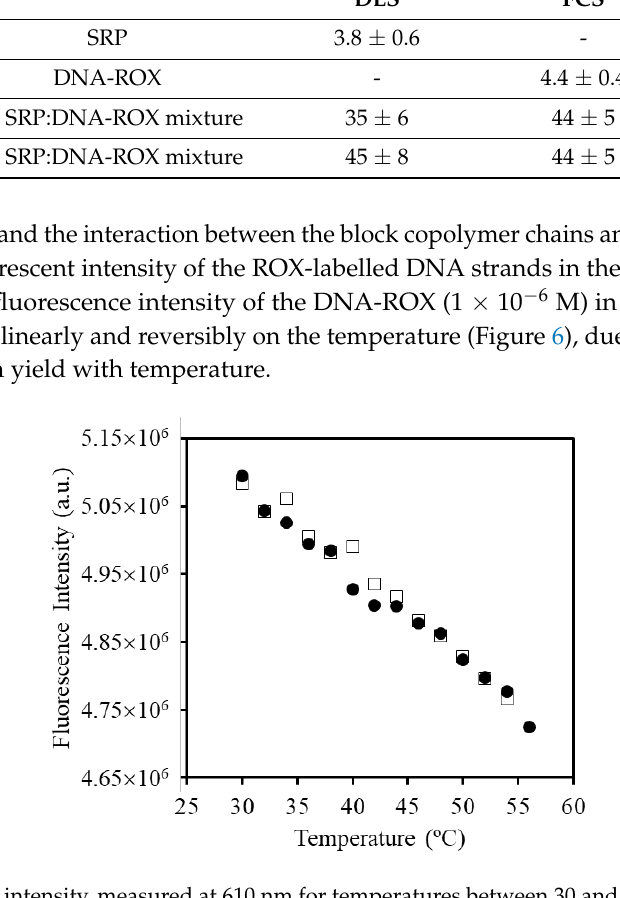
Table 1. Room temperature hydrodynamic diameters obtained for DNA-ROX, SRP and for the 1:1 and 2:1 mixtures of SRP:DNA-ROX, using dynamic light scattering (DLS) and fluorescence correlation spectroscopy (FCS).